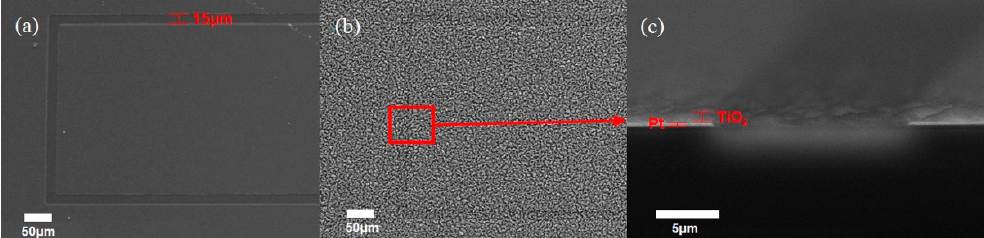
Figure 4. SEM image of ( a ) a bare Pt IDE, ( b ) after deposition of TiO 2 NPs on the Pt IDE for 16 min, and ( c ) the cross-sectional image of ( b ).